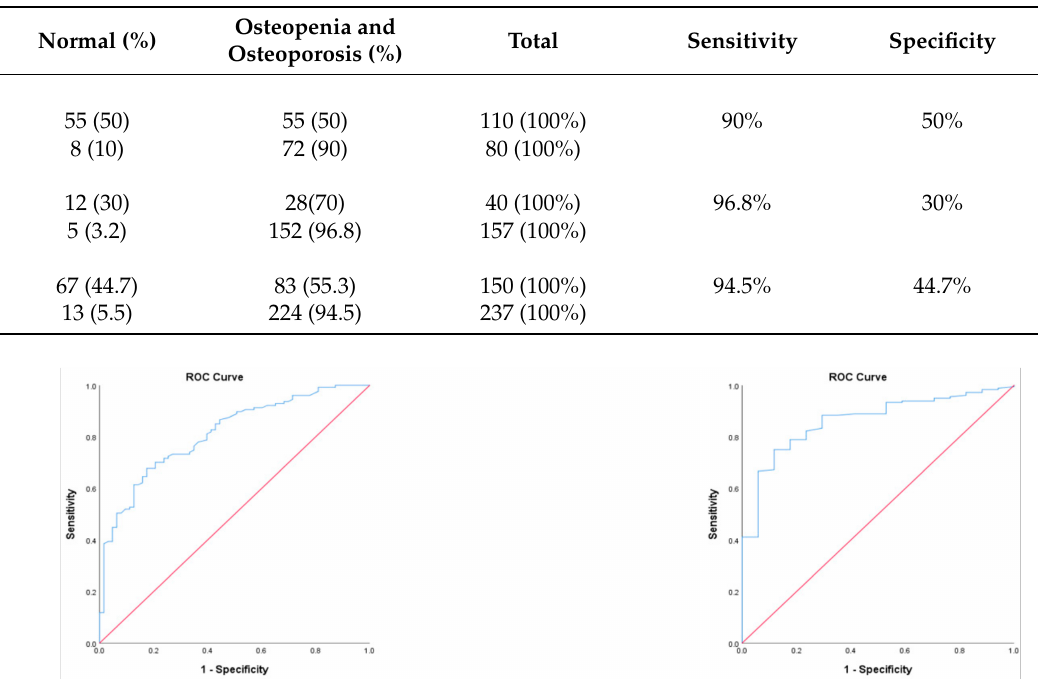
Table 5. The sensitivity and specificity at cutoff values of OSTA index ≤− 1 and t-score ≤ − 1.0 on QUS.